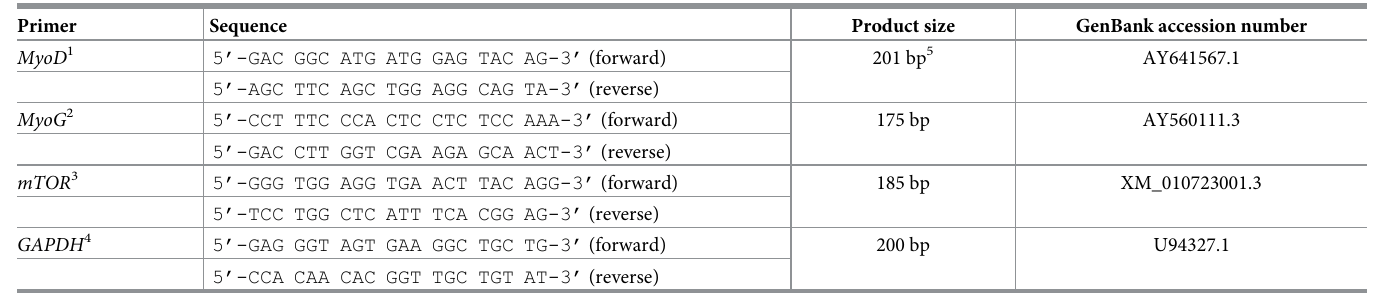
Table 1. Primer sequences for real-time quantitative polymerase chain